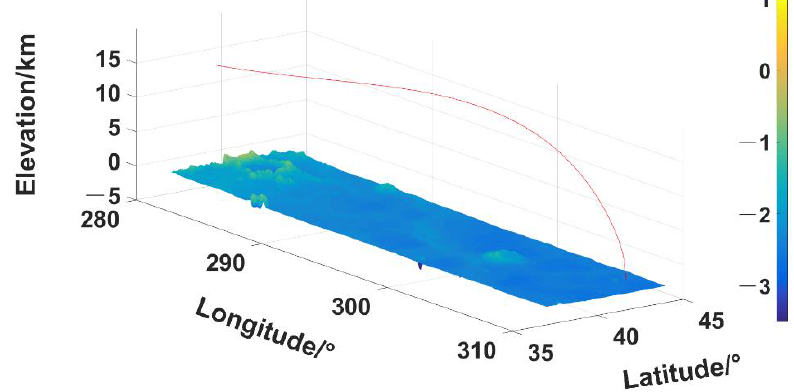
Figure 2. Descent trajectory of CE-5.